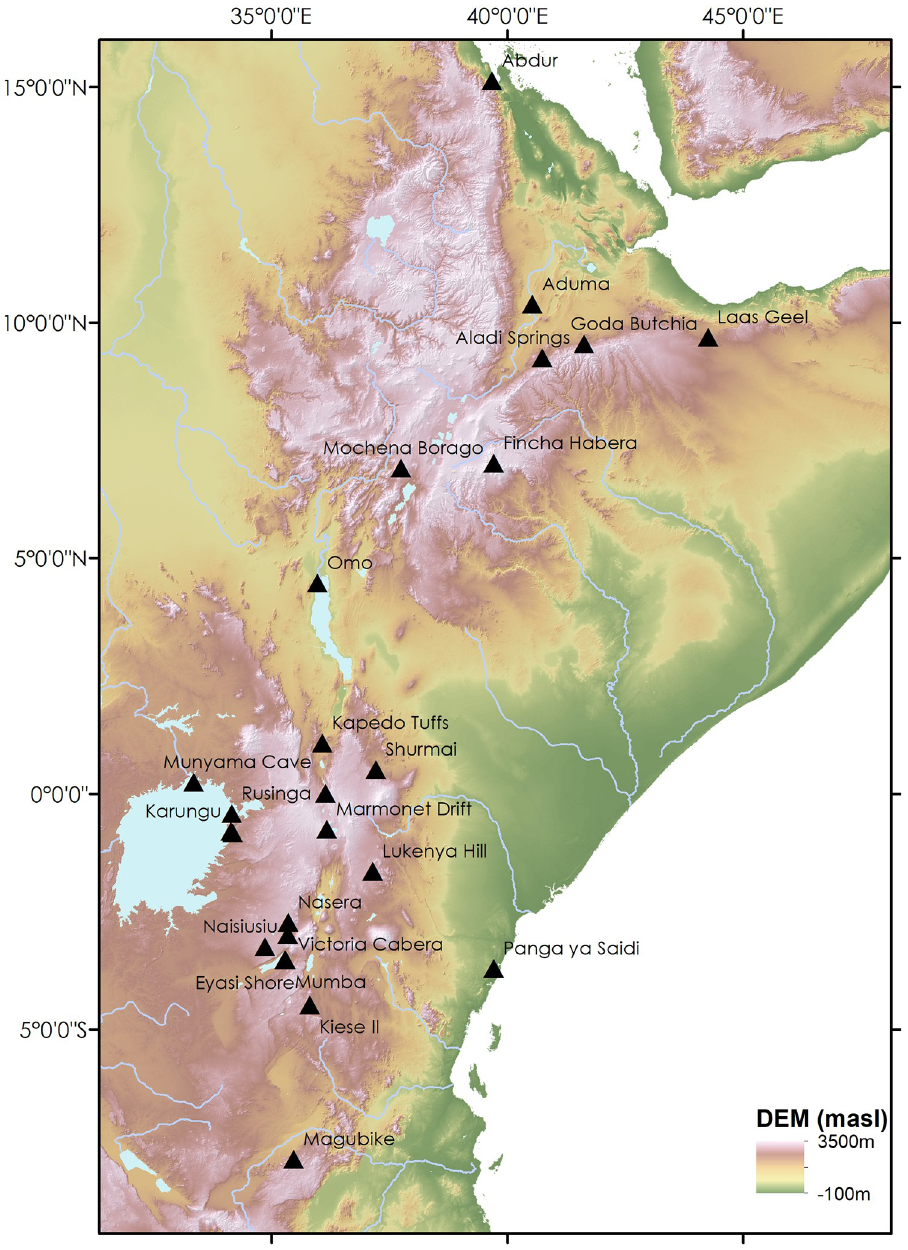
Fig 3. Map illustrating the distribution of sites contributing assemblages to the dataset for analysis, plotted on a digital elevation model (SRTM, 1 arc-second) obtained from USGS earth explorer ([61]: https://earthexplorer.